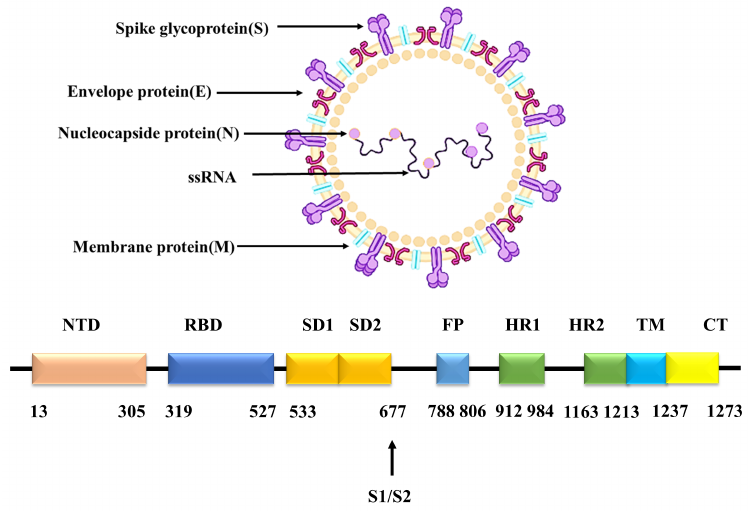
Figure 1. SARS-CoV-2